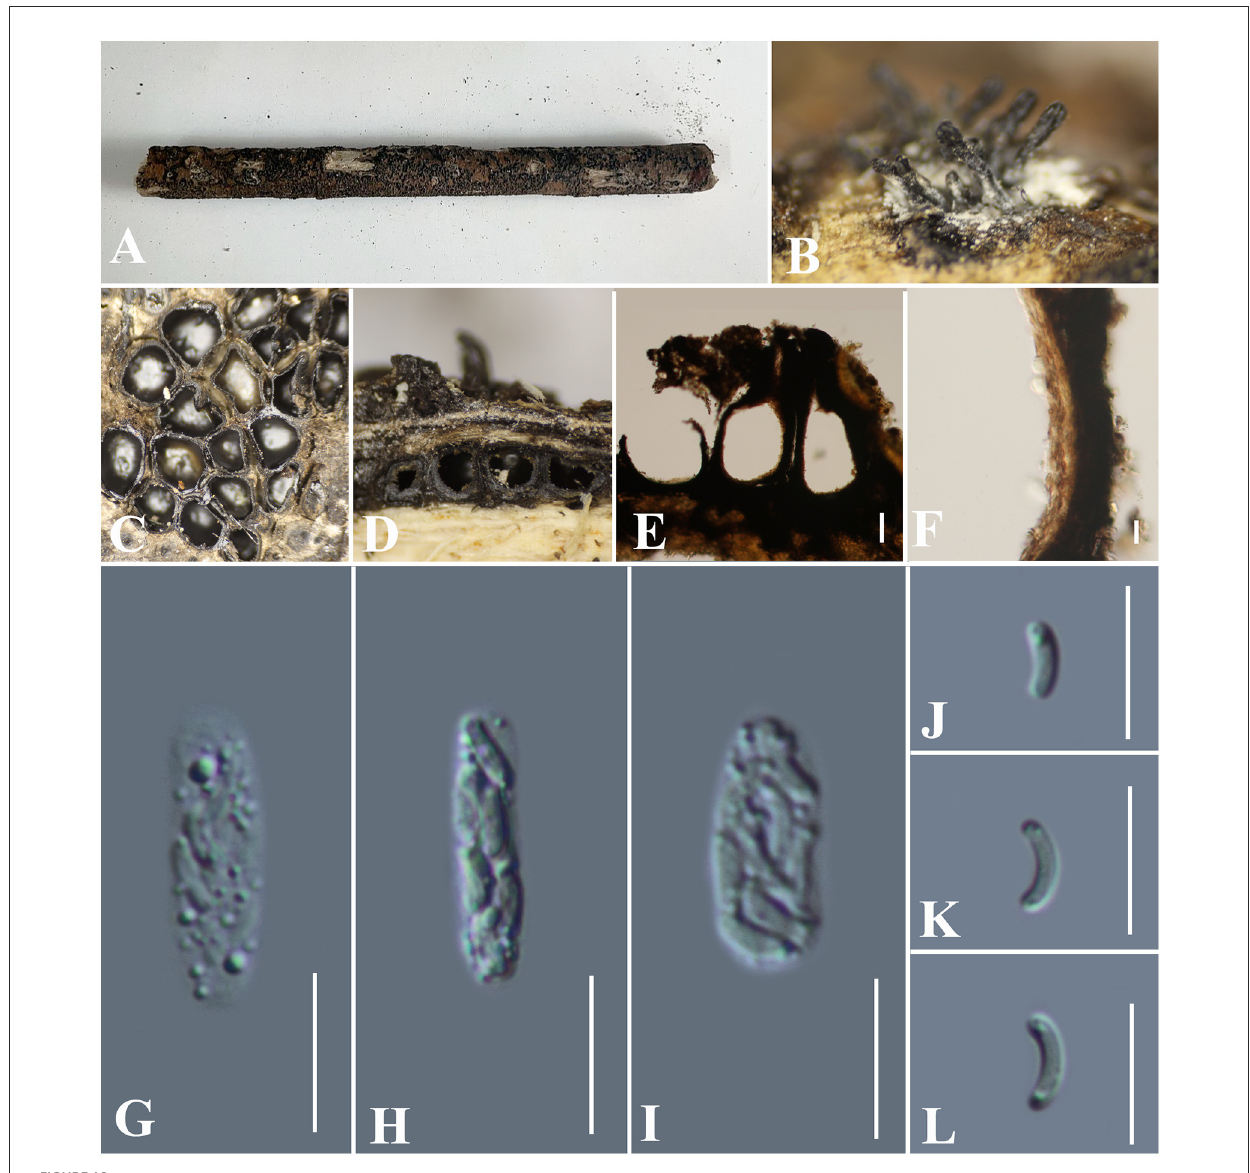
FIGURE12 Peroneutypa qianensis (GMB0431, holotype). (A) Type material. (B) Close-up of stromata. (C) Transverse section through stromata. (D) Vertical section through stromata. (E) Section through the ascostroma. (F) Peridium. (G–I) Asci. (J–L) Ascospores. Scale bars: (E) = 100 µ m; (F–L) = 10 µ